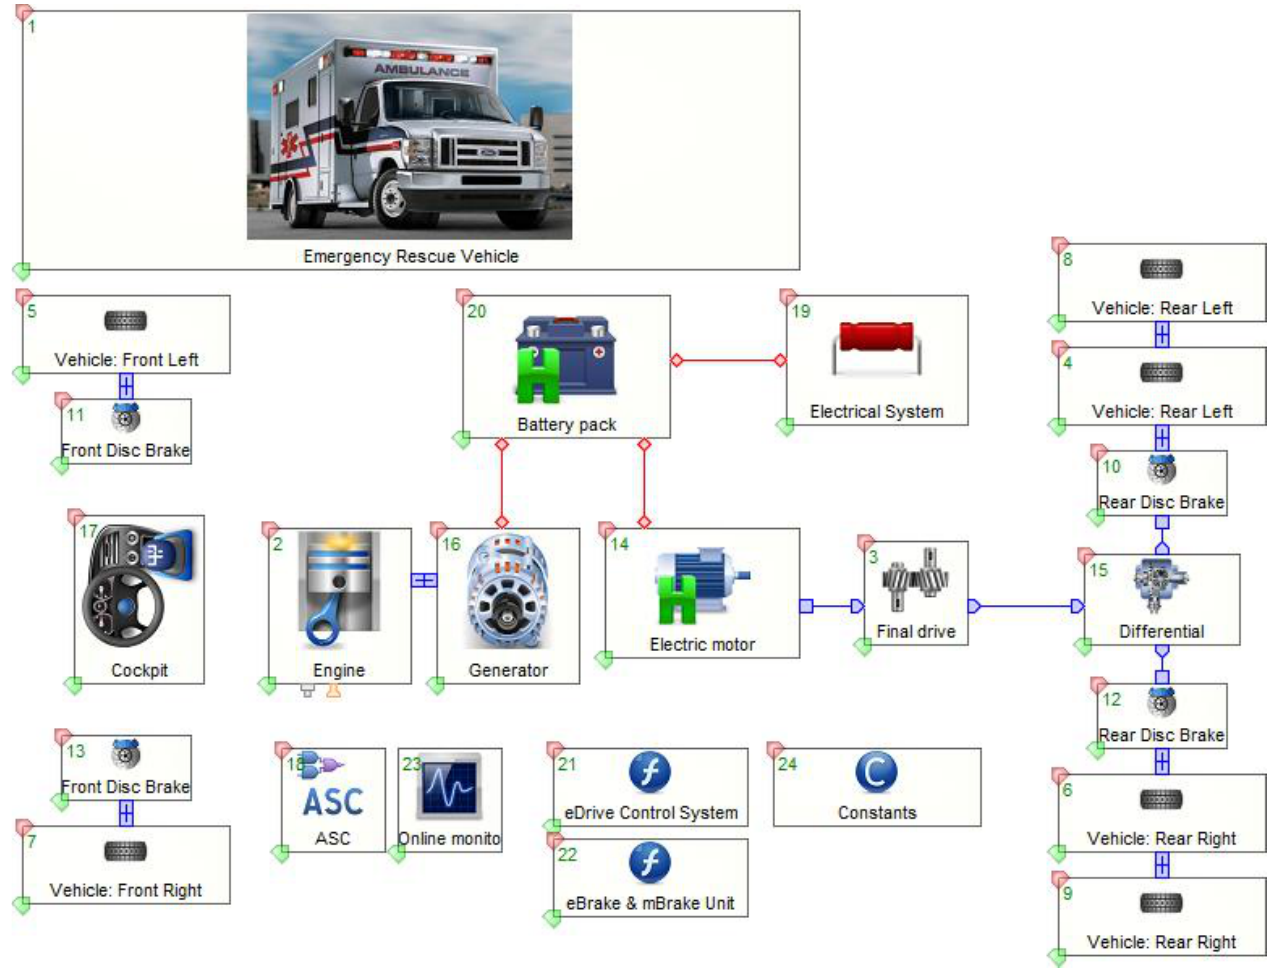
Figure 2. Simulation platform of HE-ERV.